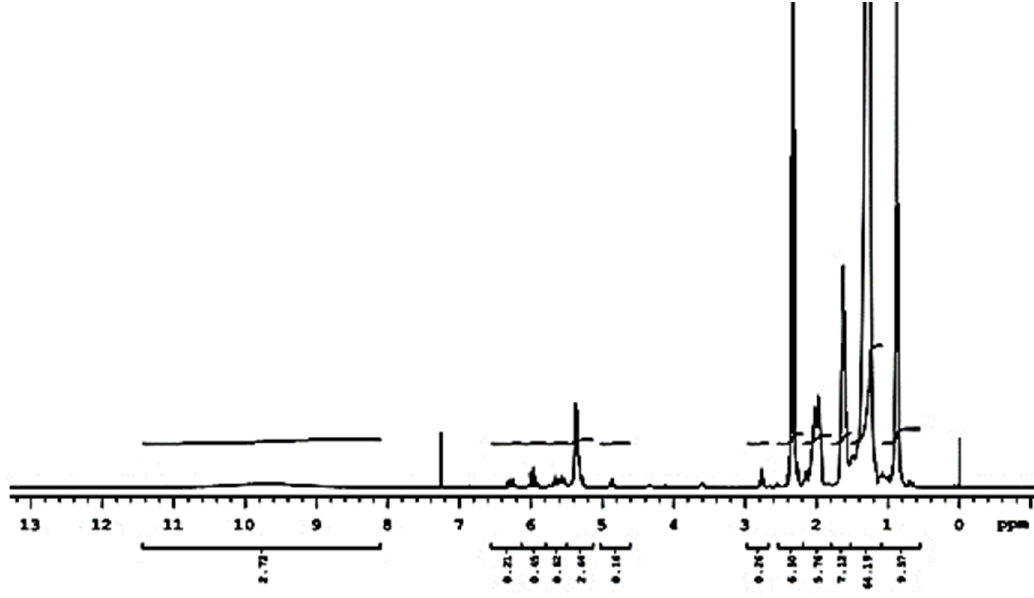
Figure 3. 1 H NMR spectrum (CD 3 OD, 300 MHz) of the isolated biosurfactant of Candida sphaerica cultivated in medium supplemented with 9% vegetable oil refinery residue and 9% corn steep liquor.